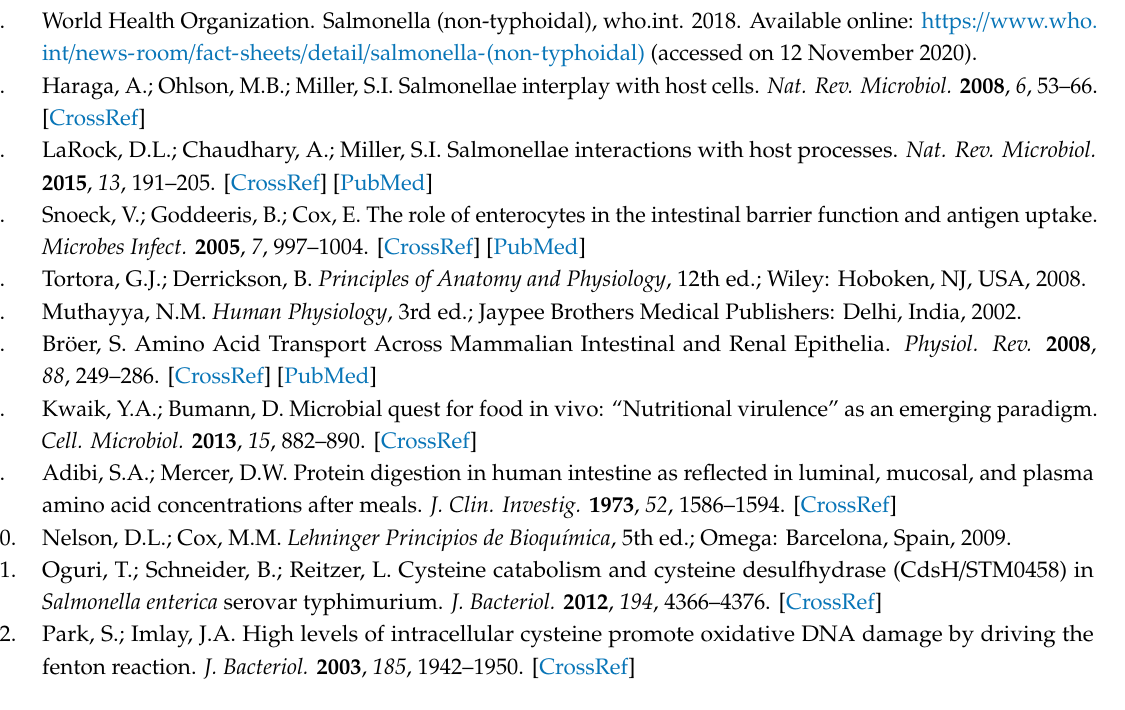
Figure S1: Growth curve in LB and M9-glucose; Figure S2. Growth curve with cysteine in LB and M9-glucose; Figure S3. Controls for cysteine supplemented replication assay; Table S1. Growth rate µ (h-1) in di ff erent culture